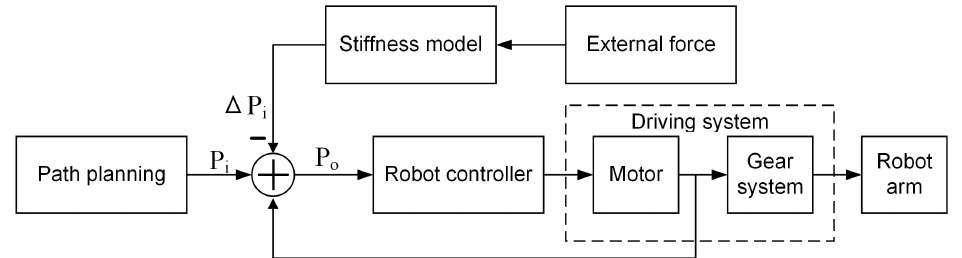
Figure 2. Schematic diagram of deformation compensation.